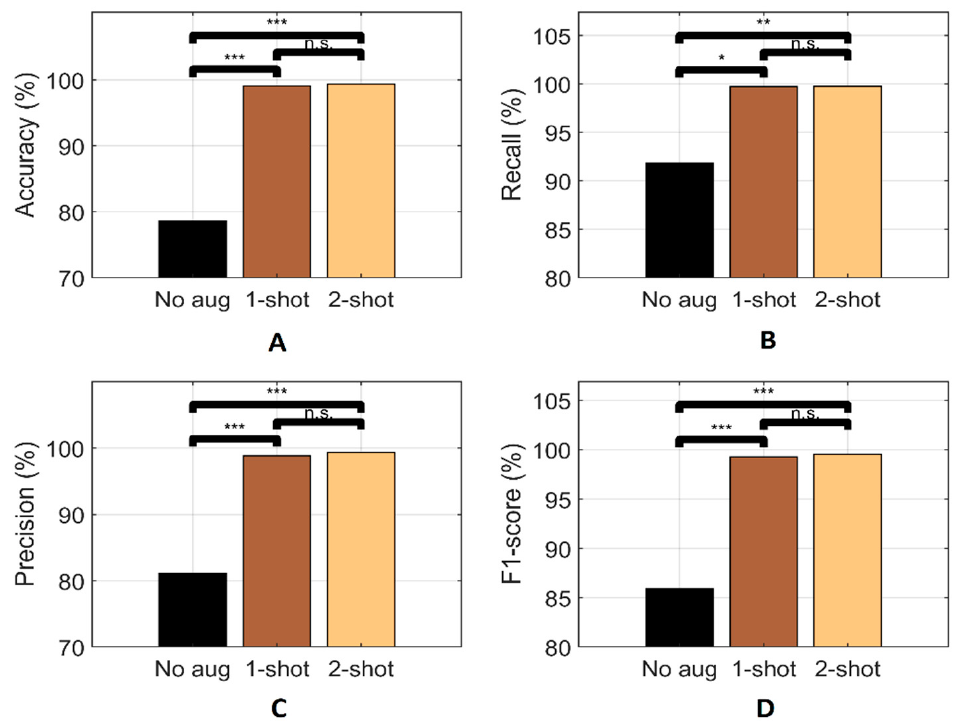
Figure 11. Results of two-sample t -test for the original dataset as well as one-shot and two-shot scenarios: ( A ) accuracy; ( B ) recall; ( C ) precision, and ( D ) F1-score. Here *- p < 0.05, **- p < 0.01, ***- p < 0.001, n.s.—not significant.